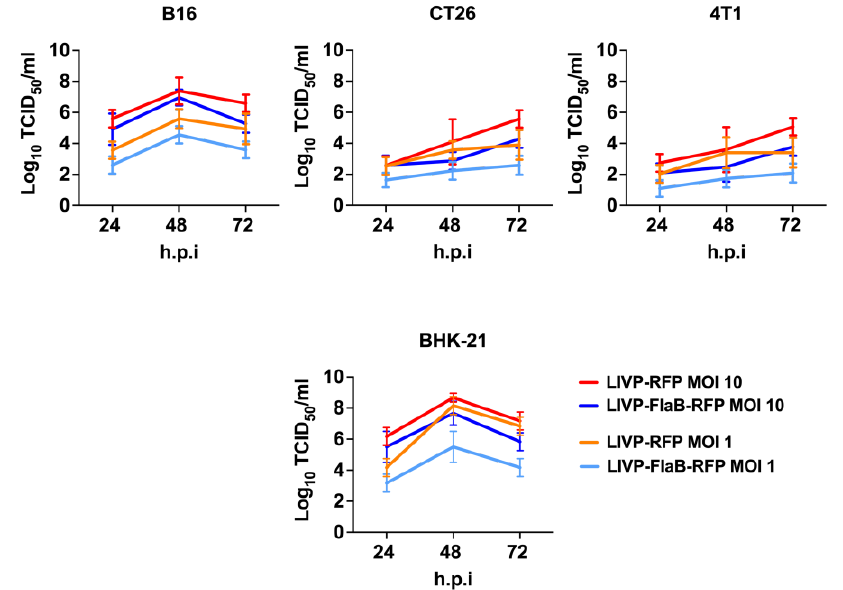
Figure 2. Viral replication efficiency. Comparison of replication efficiency of the recombinant viruses with or without expression of the flagellin transgene in various cell cultures .